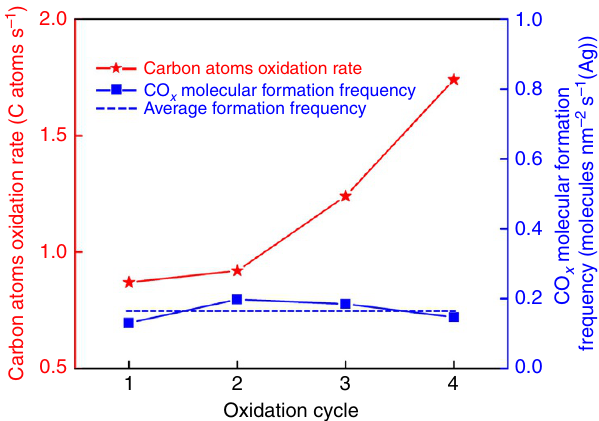
Figure 4 | Specific rate of carbon oxidation by the Ag NP shown in Fig. 2. The red line shows the oxidation rate, the blue line shows the CO x formation frequency per nm 2 of Ag, and the dashed blue line shows an average rate of the CO x formation per nm 2 of the surface of the Ag NP.